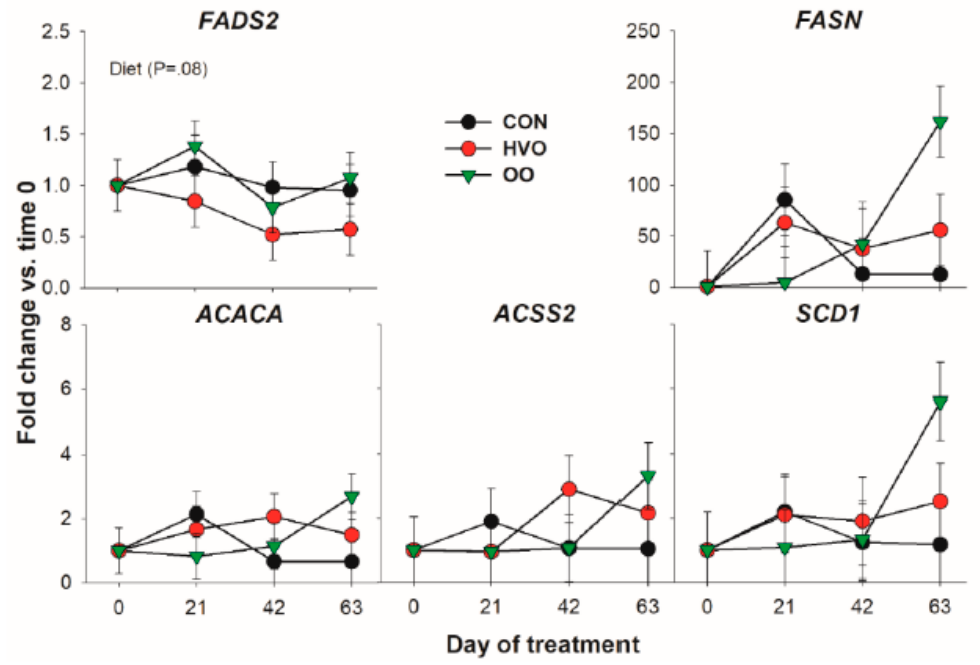
Figure 2. Effect of olive oil (OO) or hydrogenated olive oil (HVO) on transcripts coding for proteins involved in de novo fatty acid synthesis. Reported in the graph are the P-value of the overall effect of Diet.